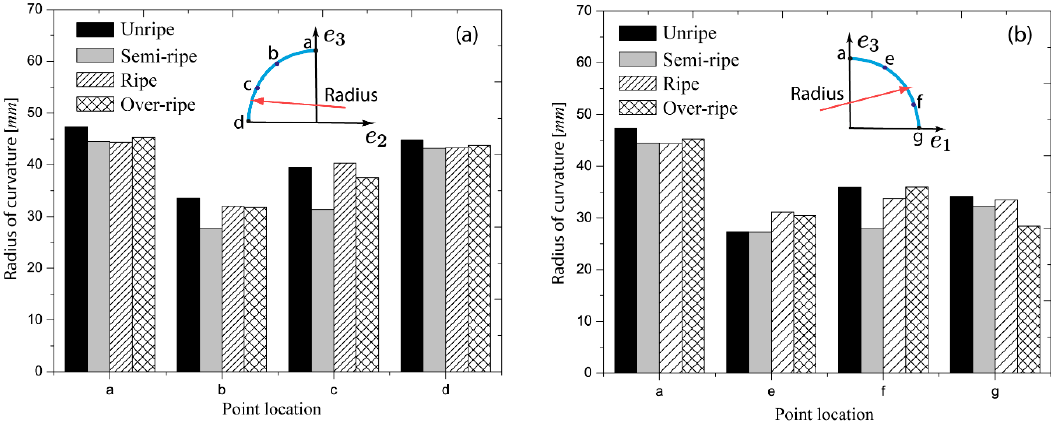
Figure 9. The radius of curvature for points: ( a ) a, b, c, d; and ( b ) a, e, f, g.